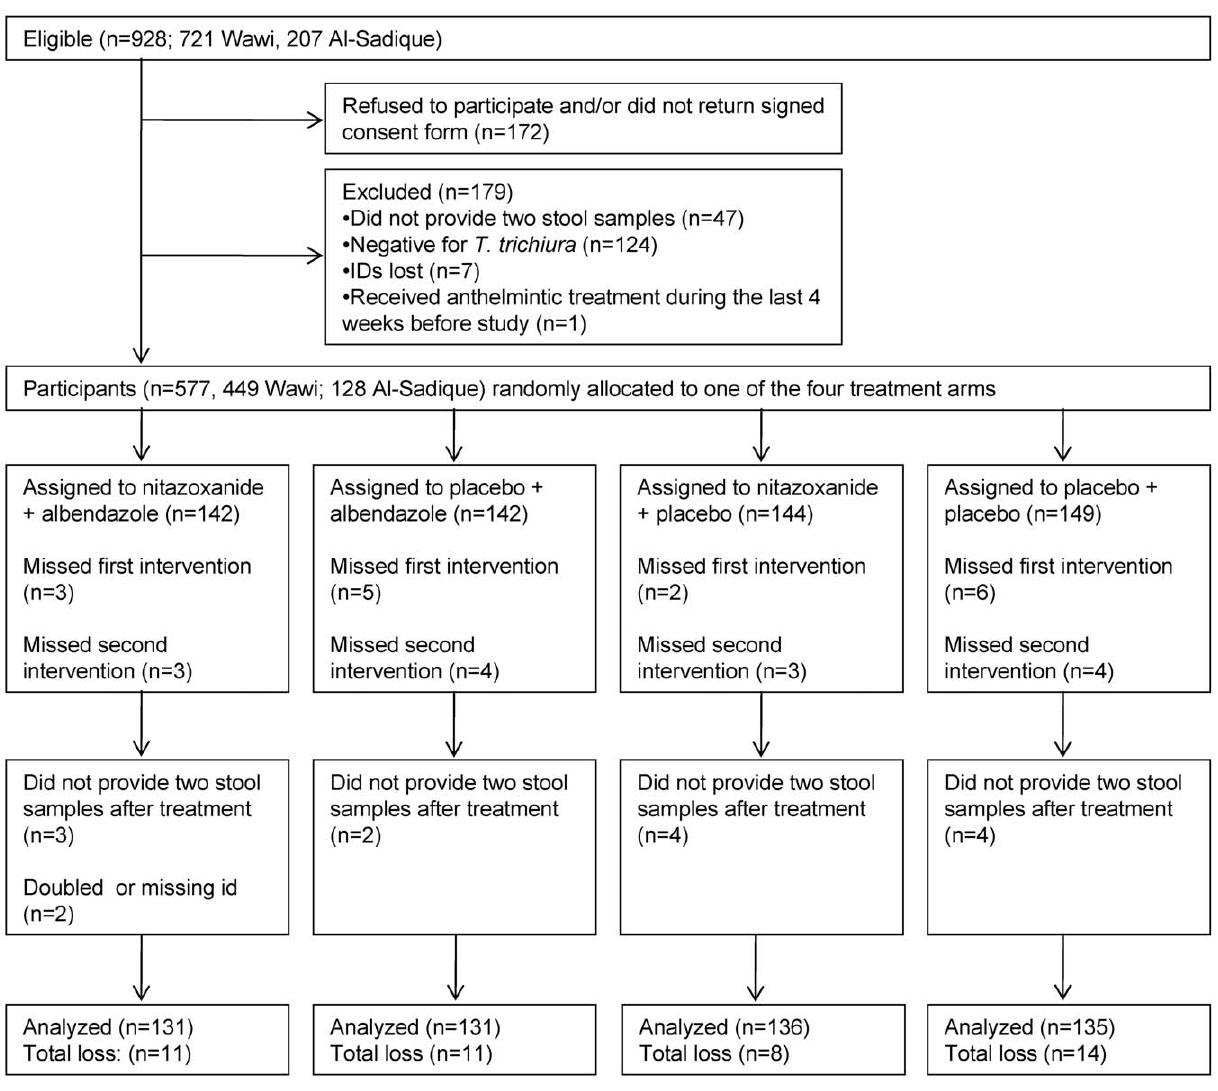
Figure 1. Flow diagram illustrating the compliance in the randomized controlled trial. Flow diagram of the randomized, placebo- controlled trial assessing the efficacy of albendazole, nitazoxanide, and albendazole combined with nitazoxanide, administered separately on two consecutive days, in the treatment of Trichuris trichiura infections.